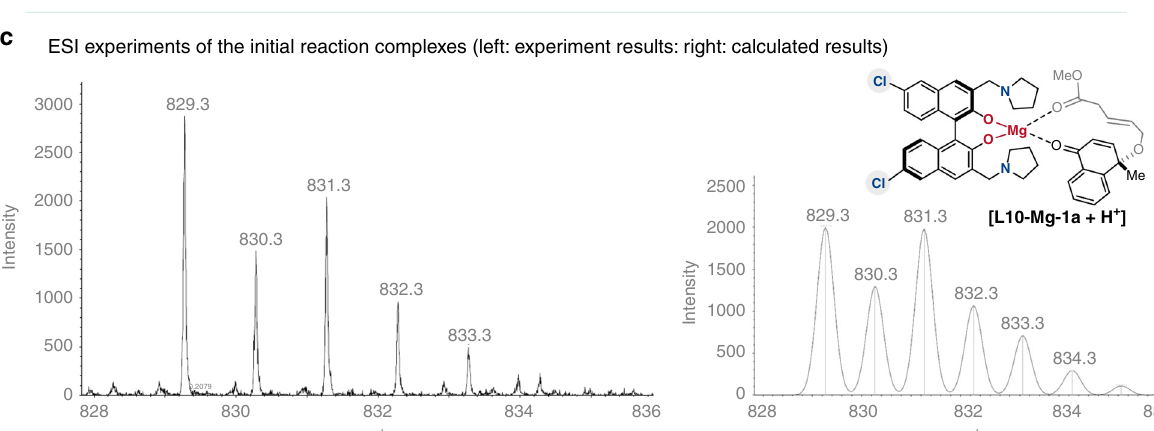
ESI experiments of the initial reaction complexes (left: experiment results: right: calculated results)